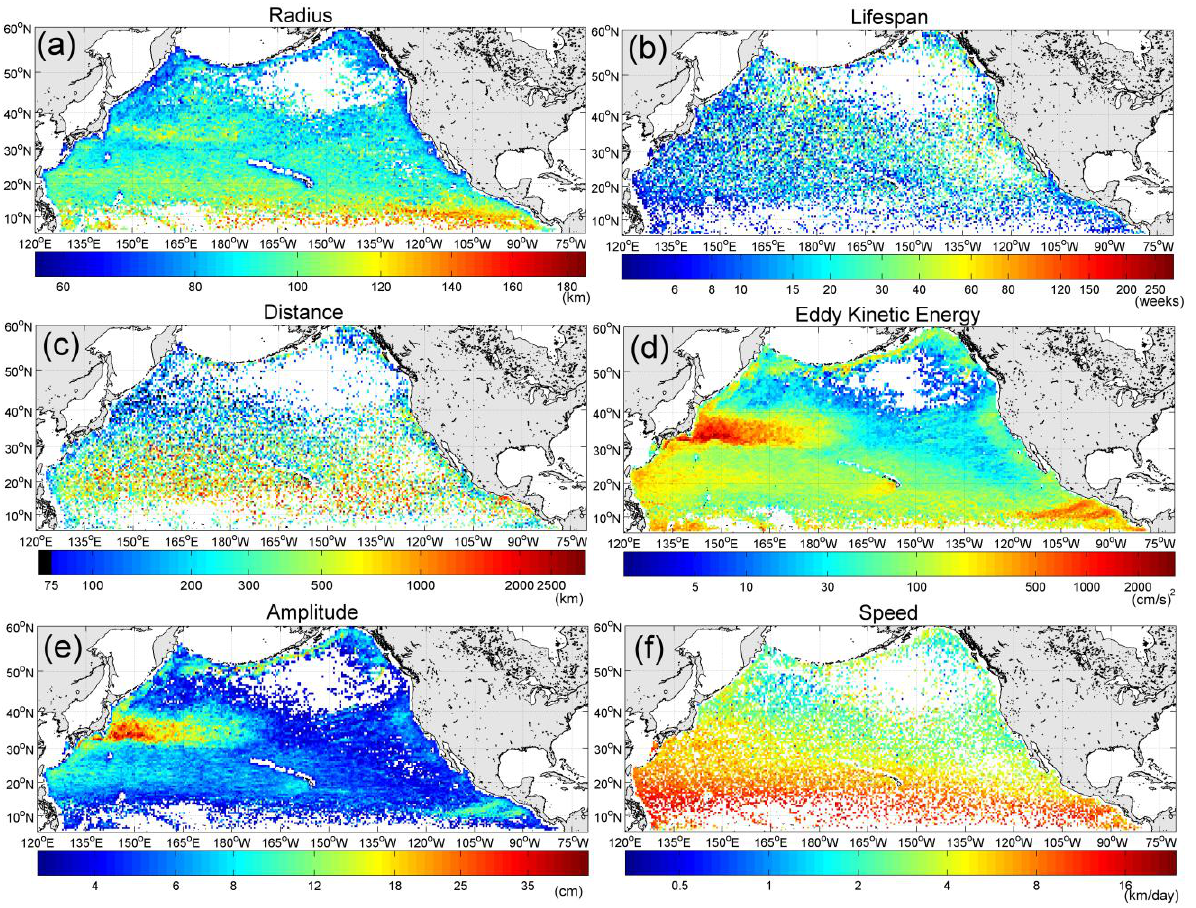
Figure 4. Maps of eddy radius ( a ); lifespan ( b ); travel distance ( c ); EKE ( d ); amplitude ( e ); and speed ( f